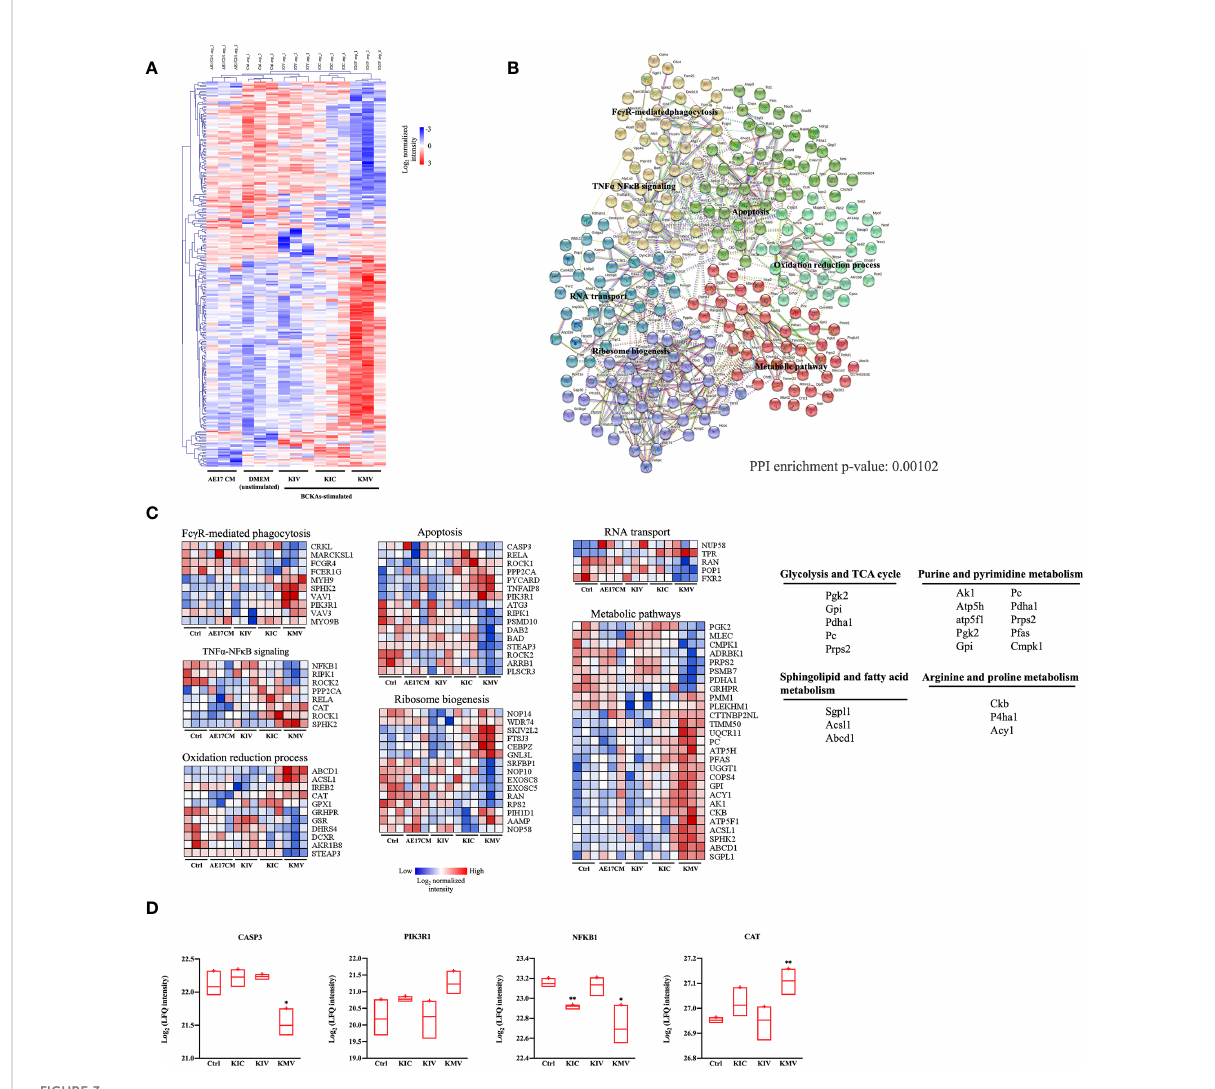
FIGURE 3 Protein signatures of responses to BCKAs stimulation. (A) , Heatmap of 243 differentially expressed proteins (one-way ANOVA, FDR q value < 0.05) between unstimulated (DMEM) and three BCKAs-stimulated iBMDM. (B) , Protein – protein interaction (PPI) network in differentially expressed proteins shown in A illustrated by STRING (PPI enrichment p-value = 0.00102). Proteins were divided into 6 clusters by k-means clustering method. Each node represents input proteins. Distinct nod colors indicated 1-6 clusters (see Table S1). Edges represent protein-protein associations (evidence). Representative KEGG terms are shown in enriched positions. (C) , Heatmap of the protein intensity of selected KEGG terms shown in (B, D), Proteomics analysis of CASP3, PIK3R1, NFKB1 and CAT in Ctrl and three BCKAs-stimulated iBMDM. The LFQ intensities were log2 transformed. Data shown the mean ± SEM of n = 3 biological experiments. * p < 0.05, ** p < 0.01 (unpaired two-tailed t